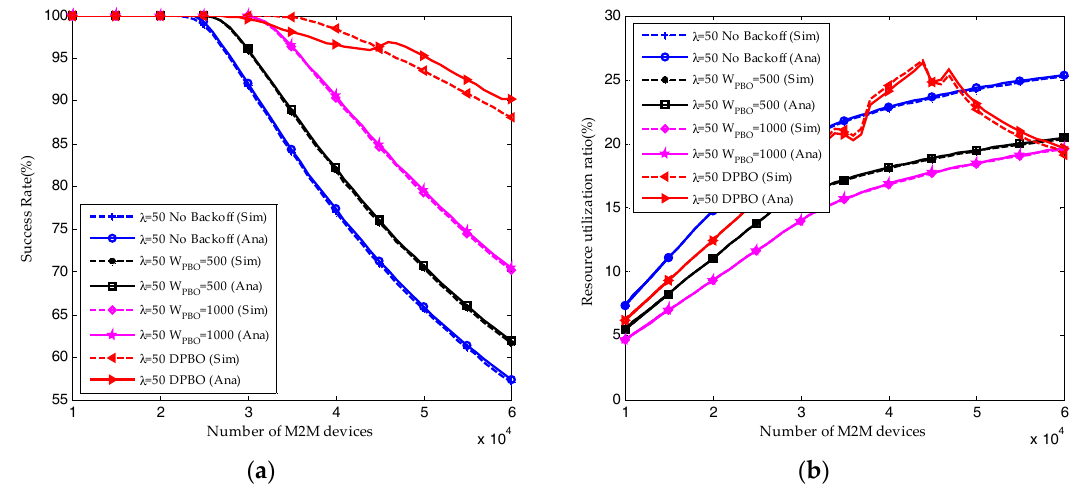
Figure 11. Performance comparisons of HSTMAC protocol between analytical and simulation results ( λ = 50, Q = 10, W BO = 20): ( a ) Average success probability of M2M traffic; ( b ) Average resource utilization ratio of M2M traffic.